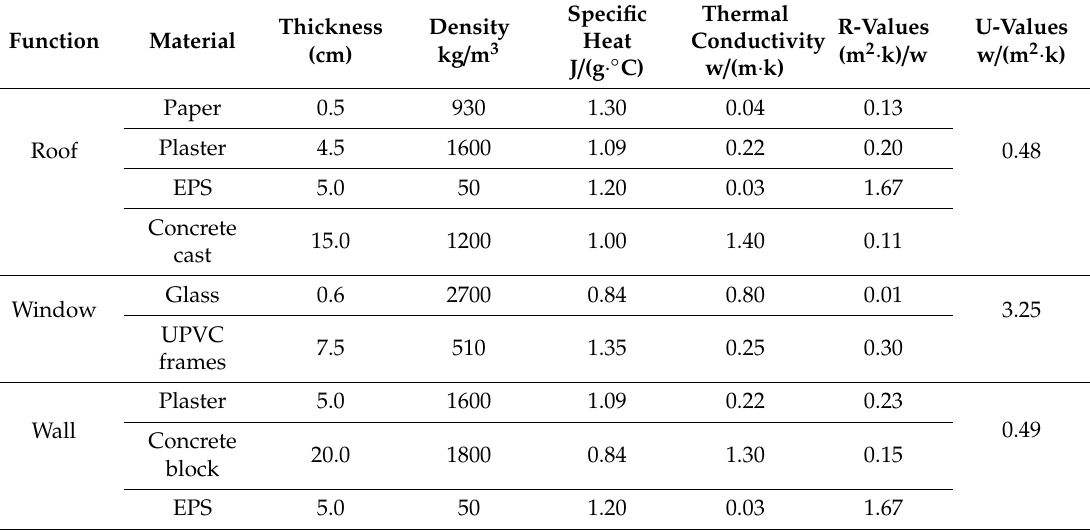
Figure 10. Solar irradiation values on the roof.